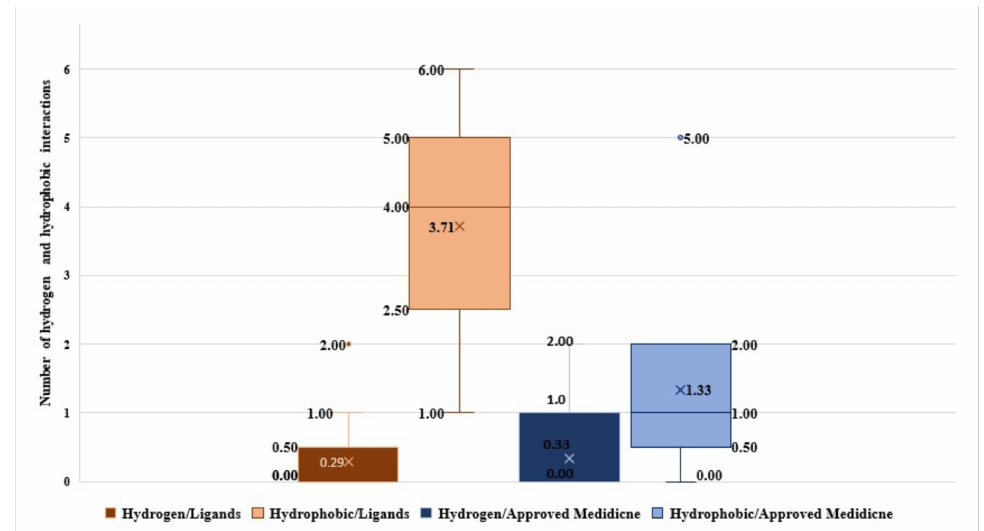
Figure 6. Box plot representing the comparison between hydrogen and hydrophobic bonds among the amino acid residues of the COVID-19 M pro substrate-binding pocket produced by docking with the six newly synthesized ligands 3a–f , Remdesivir, and